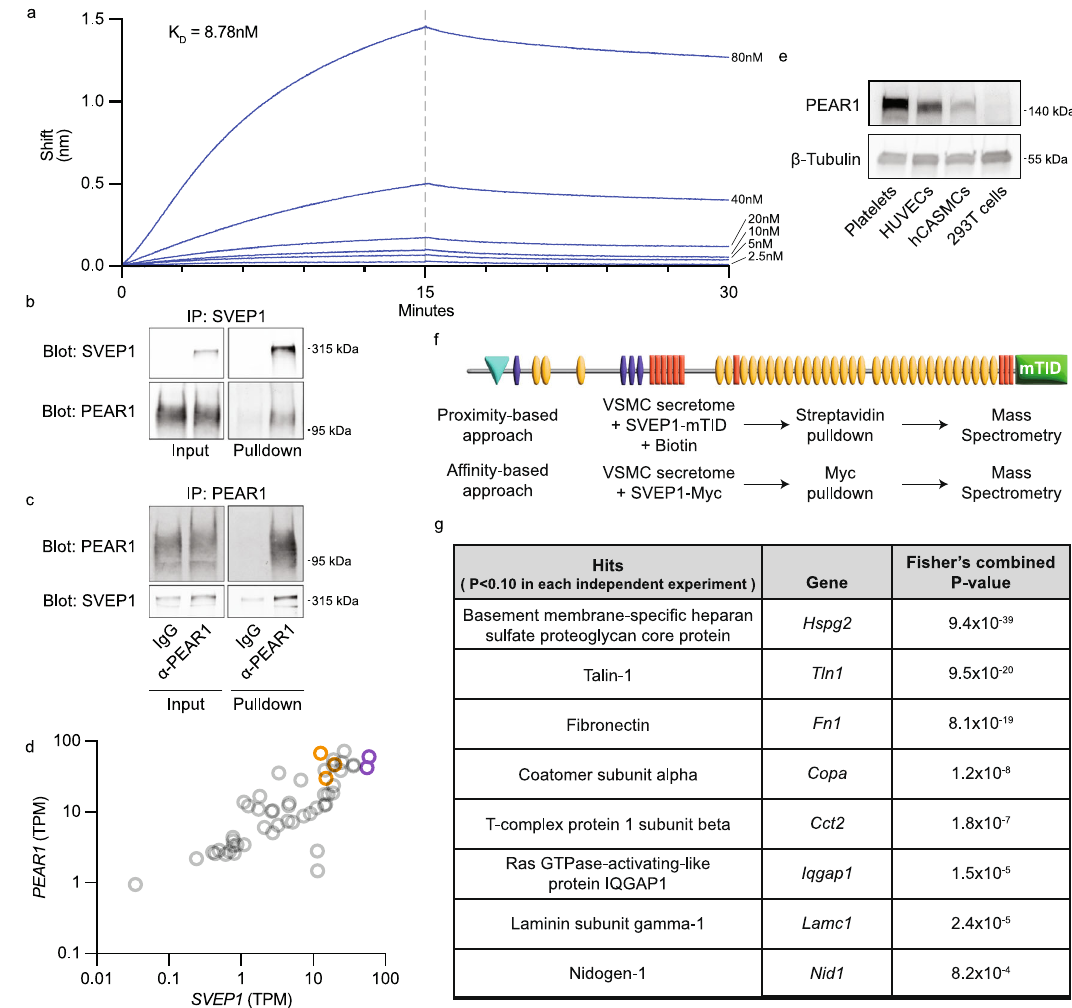
Fig. 2 | SVEP1 and PEAR1 physically interact and colocalize in tissue. a Biolayer interferometry sensorgrams. A dilution series of SVEP1 was analyzed by sensors loaded with PEAR1ECD. The dashed line represents the end of the association step and the beginning of the dissociation step. b , c Immunoblots of the indicated proteinsafterco-immunoprecipitation.NegativecontrolsincludednoSVEP1( b ),or non-speci fi c IgG ( c ).Additional details listed in “ Methods ” section. d Expression of PEAR1 and SVEP1 intranscriptspermillion(TPM)intissuesfromtheGTExdatabase. Purple circles designate adipose tissues. Orange circles designate arterial tissues.